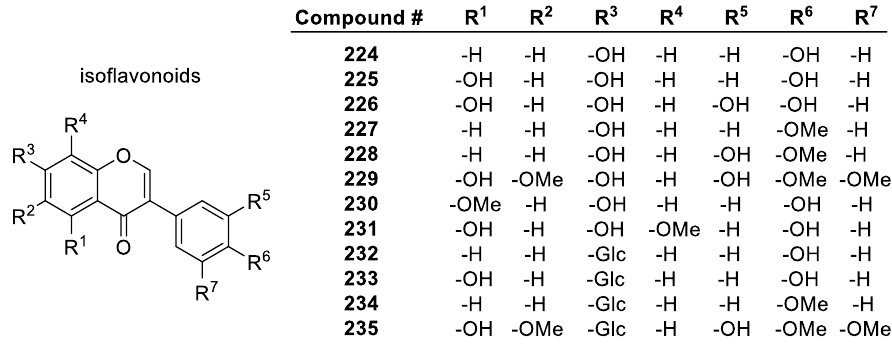
Figure 14. Representative examples of isoflavonoids with antioxidant effect.